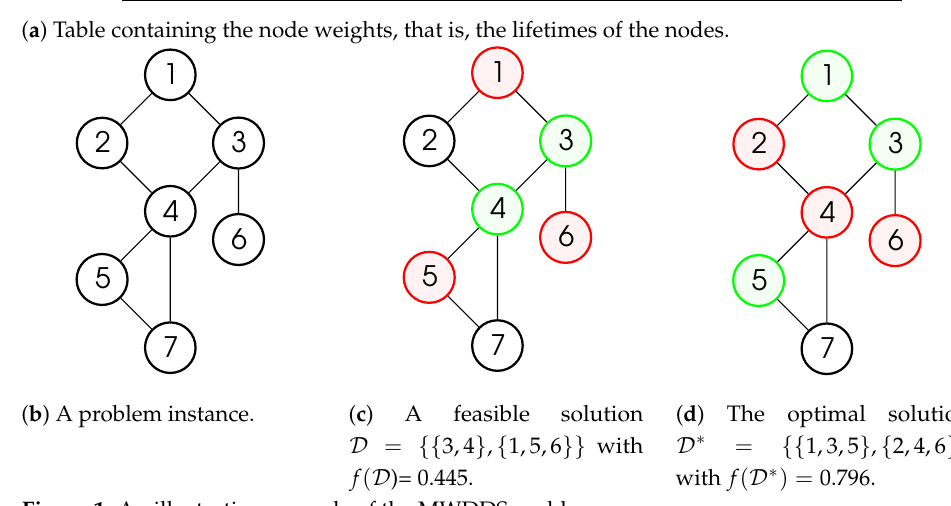
Figure 1. An illustrative example of the MWDDS